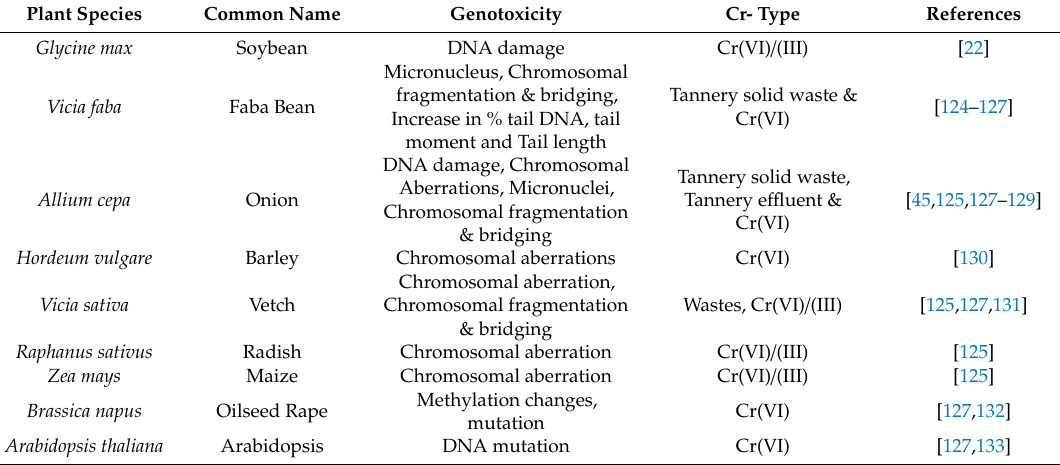
Table 4. Chromium-induced genotoxicity in various plant